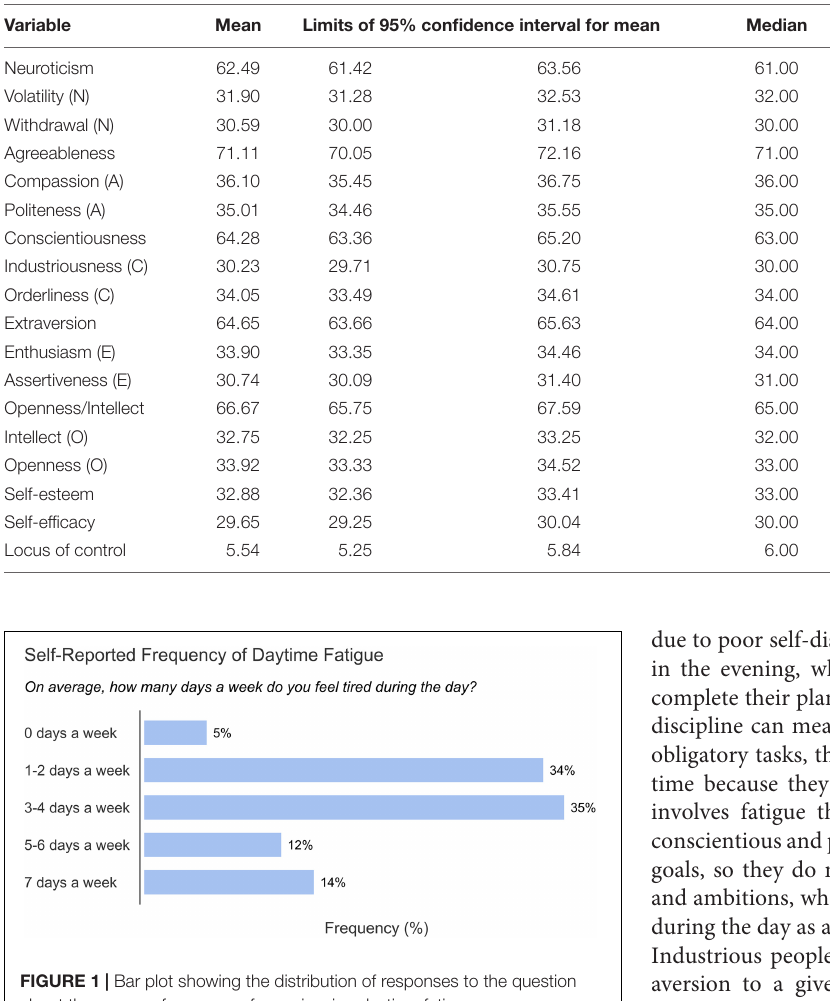
TABLE 1 | Basic descriptive statistics for personality variables.